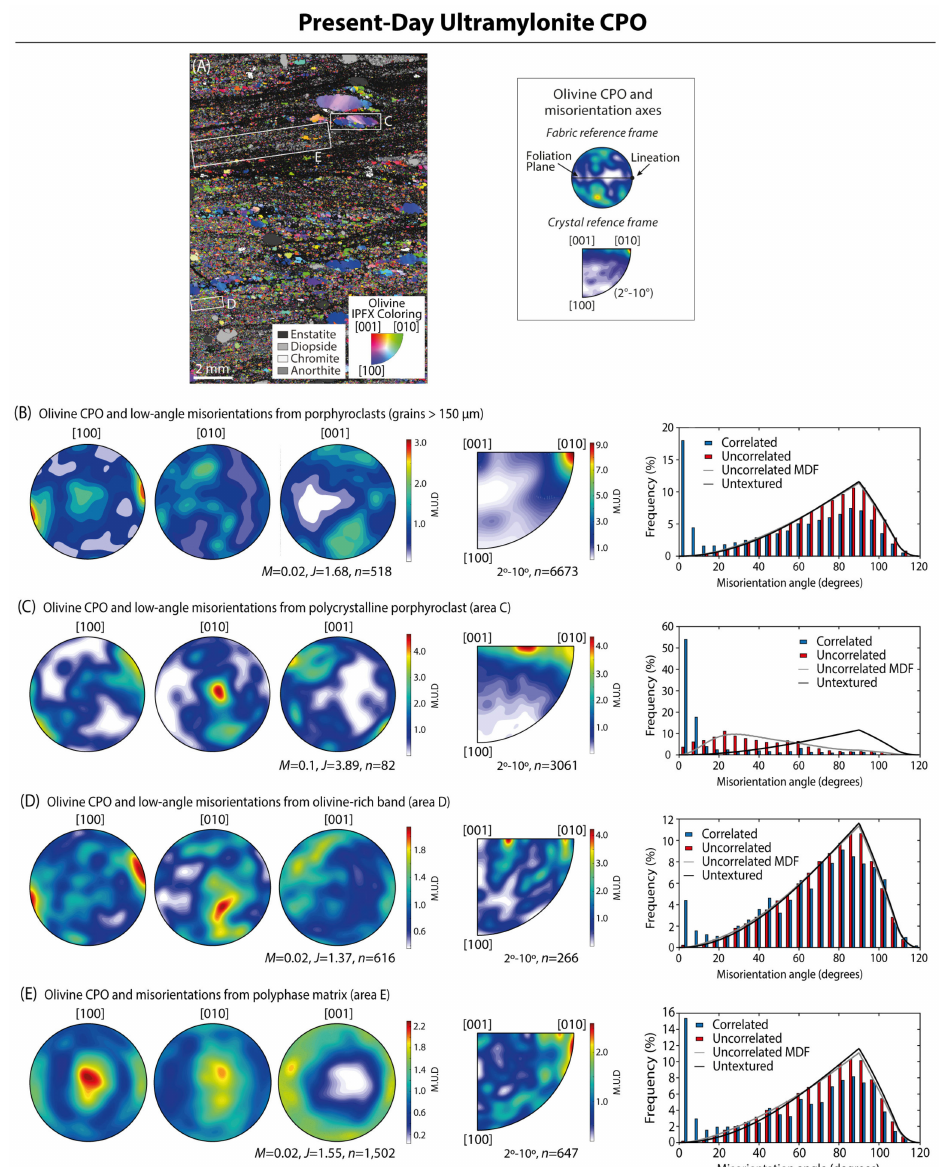
Figure 6. Crystallographic preferred orientation (CPO) and misorientation results from the present-day ultramylonite. ( A ) Combined EBSD phase and inverse pole figure (IPF) map illustrating the microstructure of the polyphase band. The inverse pole figure map of olivine crystallographic axis orientation is colored relative to the lineation, which is parallel to the upper edge of the map (IPF-X coloring). Black lines correspond to grain boundaries. Black areas correspond to zero solutions (not-indexed domains). Step size is 8 µ m. ( B ) CPO, distribution of low-angle misorientation axes, and misorientation angles distribution for olivine porphyroclasts from ( A ). ( C ) Same as ( B ) for olivine in the polycrystalline porphyroclast from area ( C ). ( D ). Same as ( B ) for olivine in a fine-grained, olivine-rich band from area ( D ). ( E ) Same as ( B ) for olivine in the polyphase matrix in area ( E